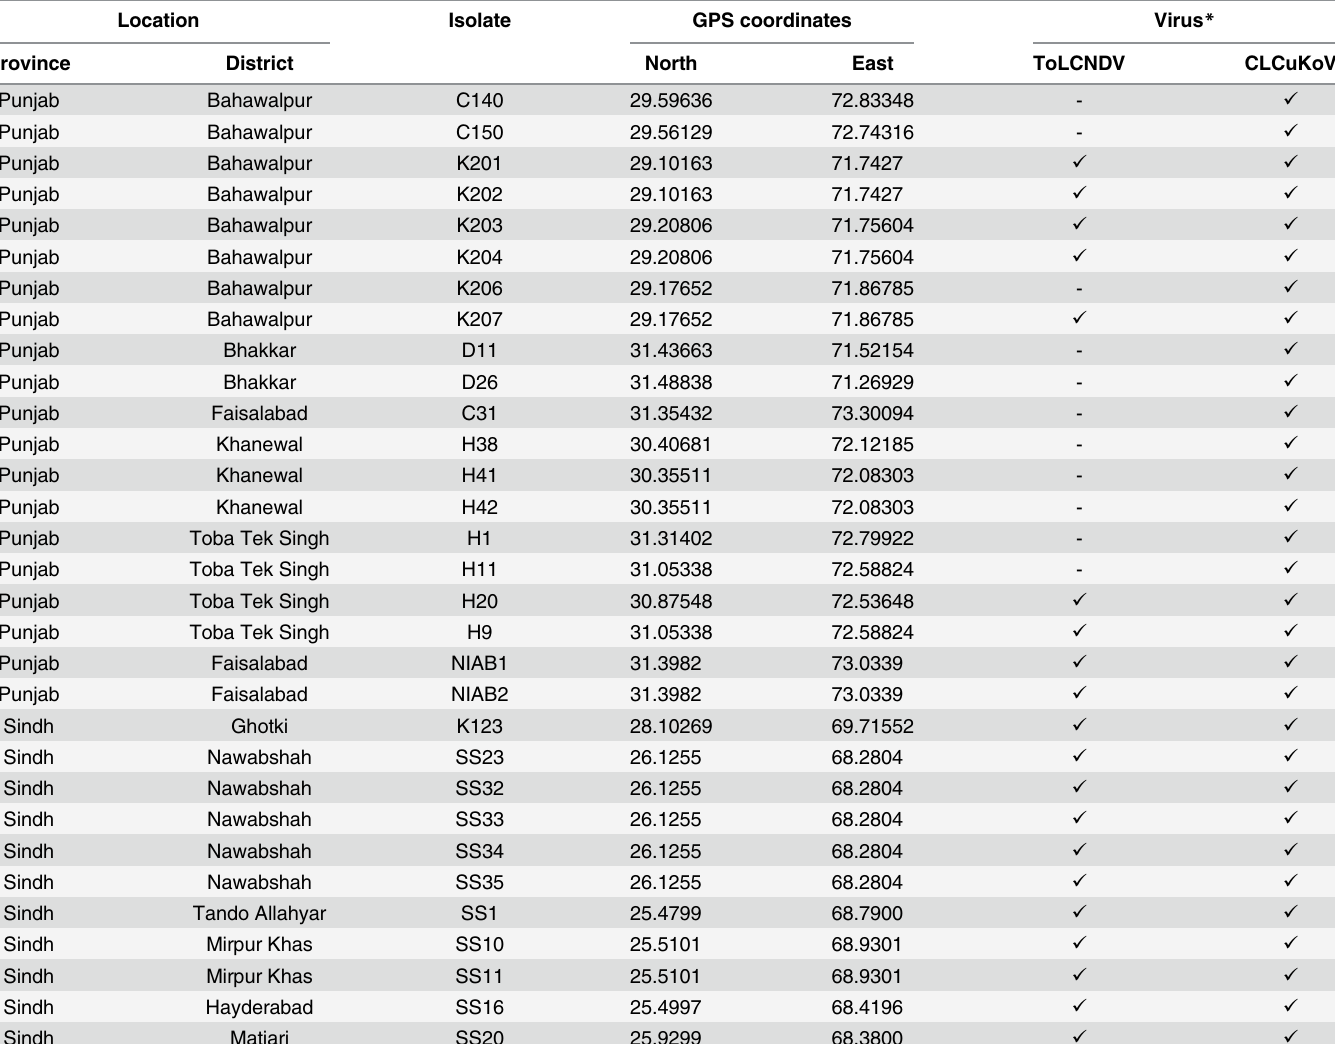
Table 1. Origins offield collected cotton samples and presence of viruses.